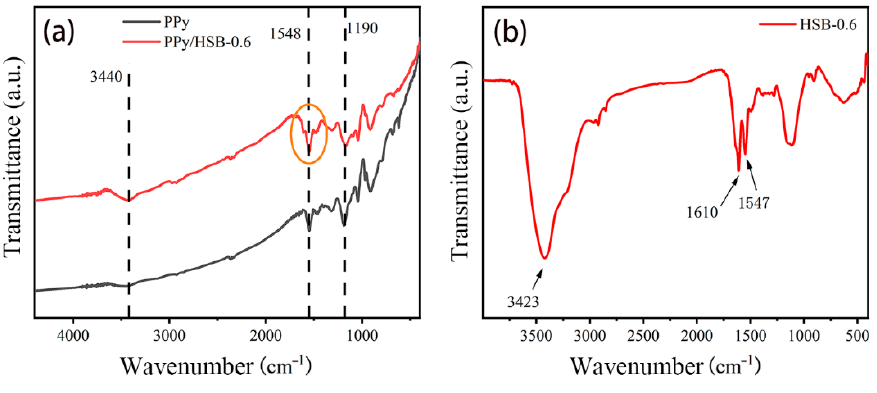
Figure 2. FT-IR spectra of pure PPy, HSB/PPy-0.6 ( a ) and HSB-0.6 ( b ).